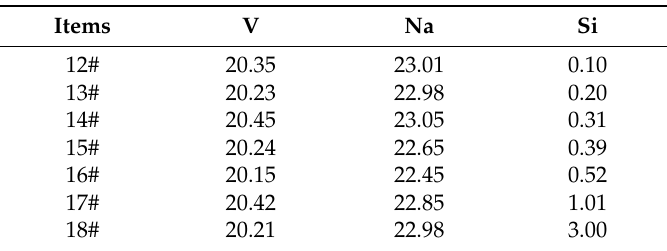
Table 3. Main chemical compositions of the simulated feed vanadium solutions with different silicon concentrations,